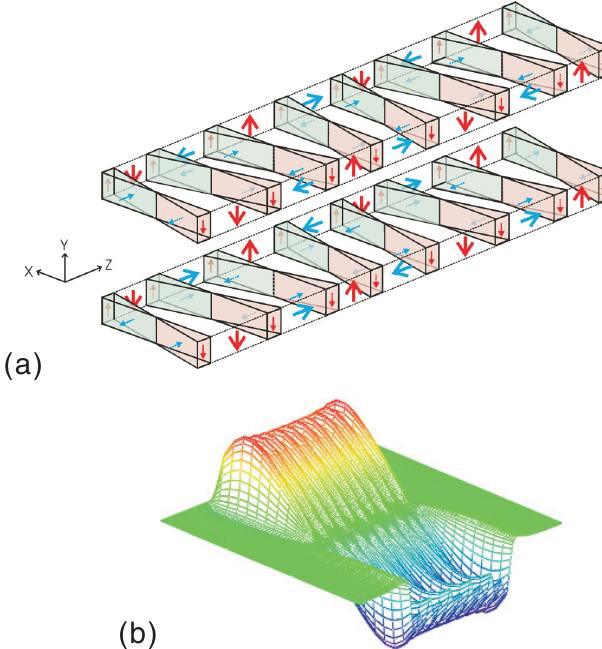
FIG. 11. (Color) Magnet structure and the magnetic field dedi- cated to producing the field gradient in the experimental model of the EF wiggler. (a) Magnet structure producing the field gradient. The EF wiggler consists of four rows of triangular prisms in the z direction superimposed to the magnet structure of a conventional planar wiggler. Although each prism has magne- tization in the y direction and the z direction, the y magnetization mainly contributes to the field gradient. All the prisms in the upper and lower rows in the positive x side have the downward magnetization and those in the negative x side have upward on the median plane magnetization. (b) The magnetic field B y produced only by the four rows of the triangular prisms. The magnetic field is derived from that of the EF wiggler calculated with the 3D program by subtracting the magnetic field of the conventional planar wiggler. The magnetic field distribution shows a one-cycle oscillation in the x direction with a linear field gradient near the